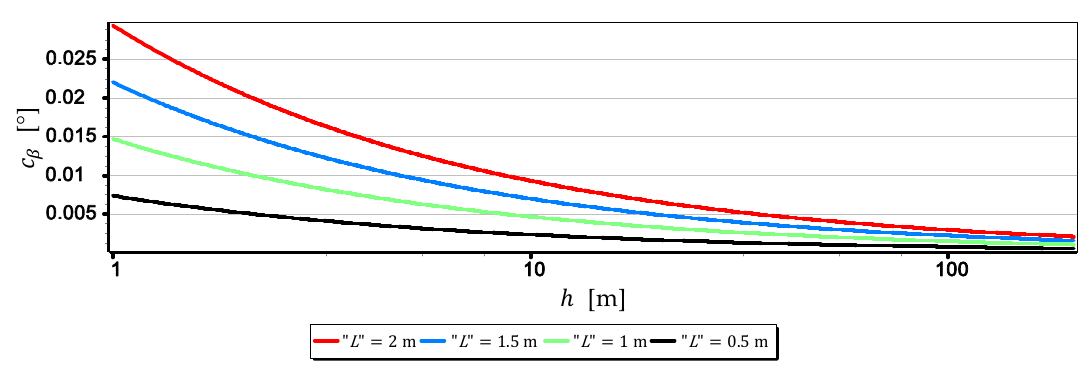
Figure 12. Measurement resolution of the horizon slope 𝑐 𝛽 as a function of ℎ for chosen wave heights "𝐿" ( 𝐹𝑂𝑉 𝐻 = 59.94° – DJI FC550RAW).